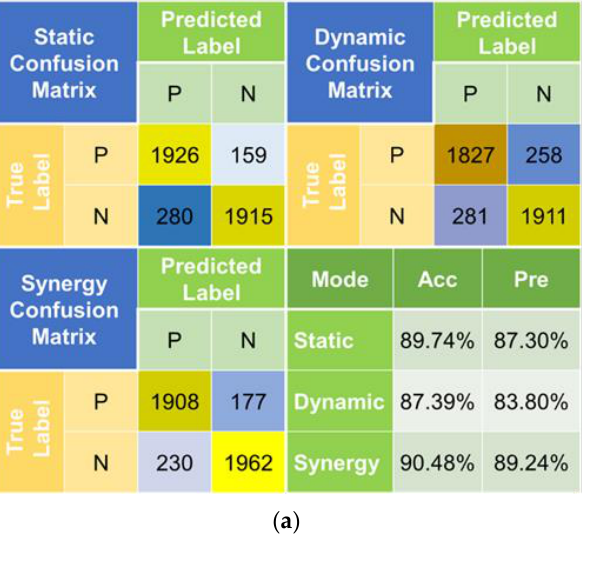
Figure 6. Assessment accuracy comparison and performance analysis of different feature modes: ( a ) evaluation metrics, top-left: static model confusion matrix, top-right: dynamic model confusion matrix, bottom-left: synergy model confusion matrix, bottom-right: accuracy indices; ( b ) ROC curve of synergy, static, and dynamic feature modes.